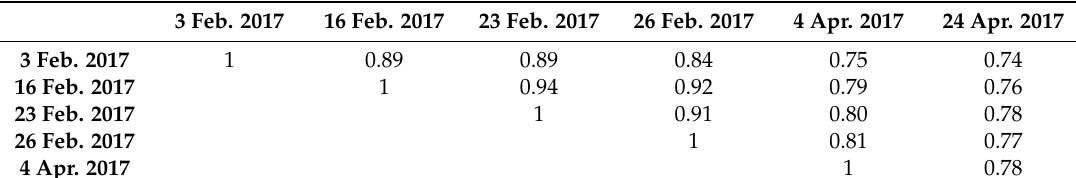
Table 2. Pearson coefficient of correlation (R) between the classification (most frequent class after the bootstrap process) obtained at each date.